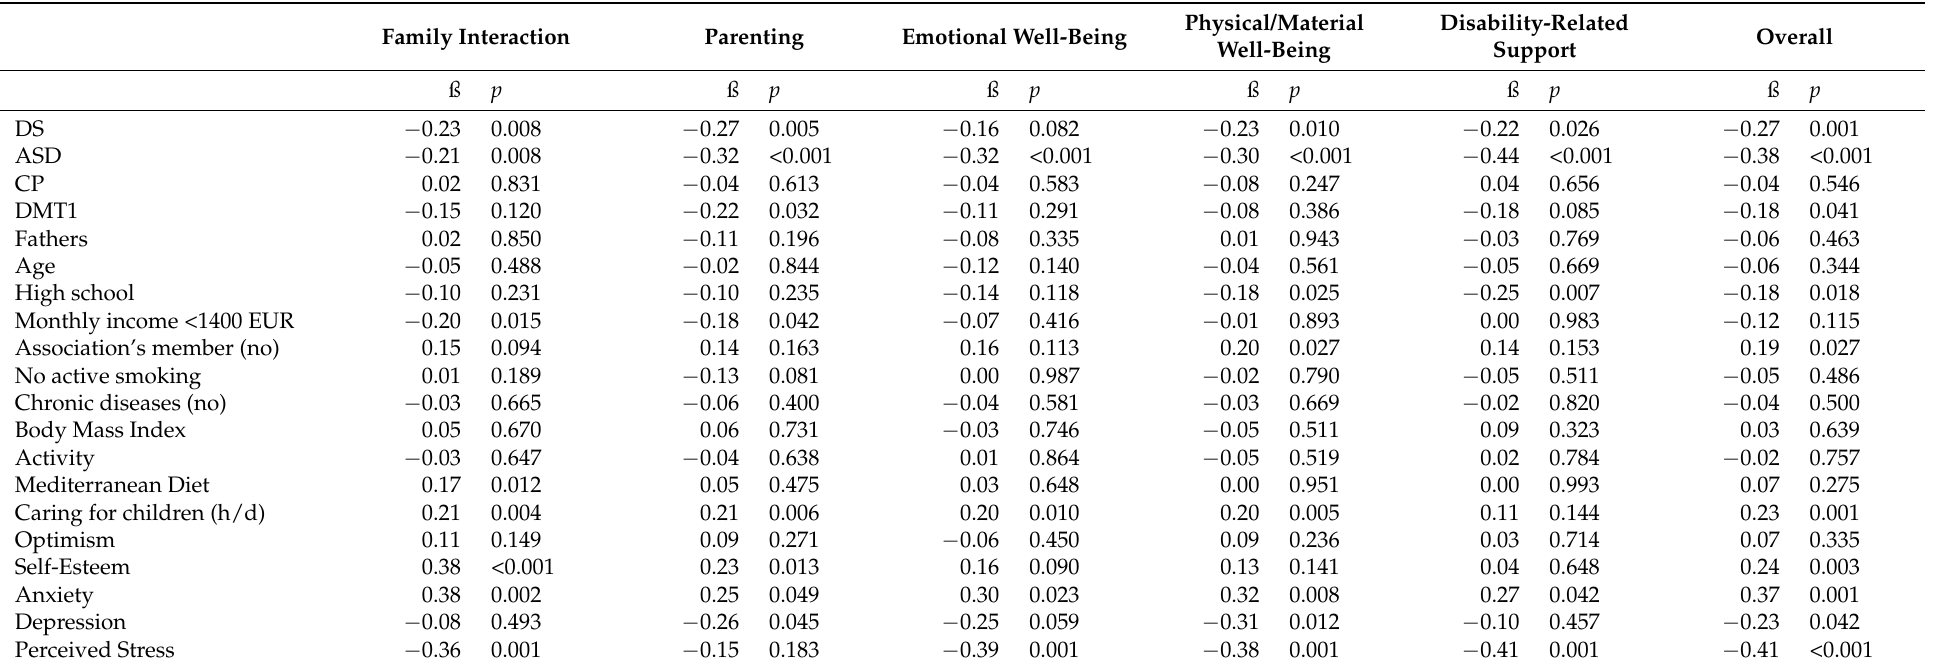
Table 2. Association between family quality of life and parents’ characteristics using multivariate linear regression. Family Interaction Parenting Emotional